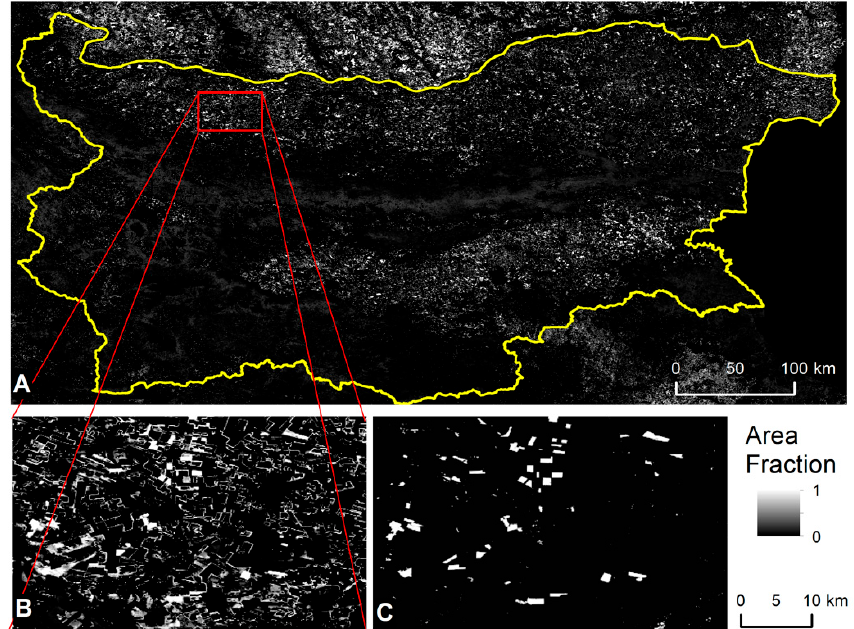
Figure 6. ( A ) Estimated area fraction image for the winter rapeseed class derived by ANN sub-pixel classification of PROBA-V 100 m NDVI time series over Bulgaria. ( B ) Excerpt from the image in (A) for part of “Knezha” test site. ( C ) True area fraction image for the same region as (B) derived from the reference Sentinel-2 classification.